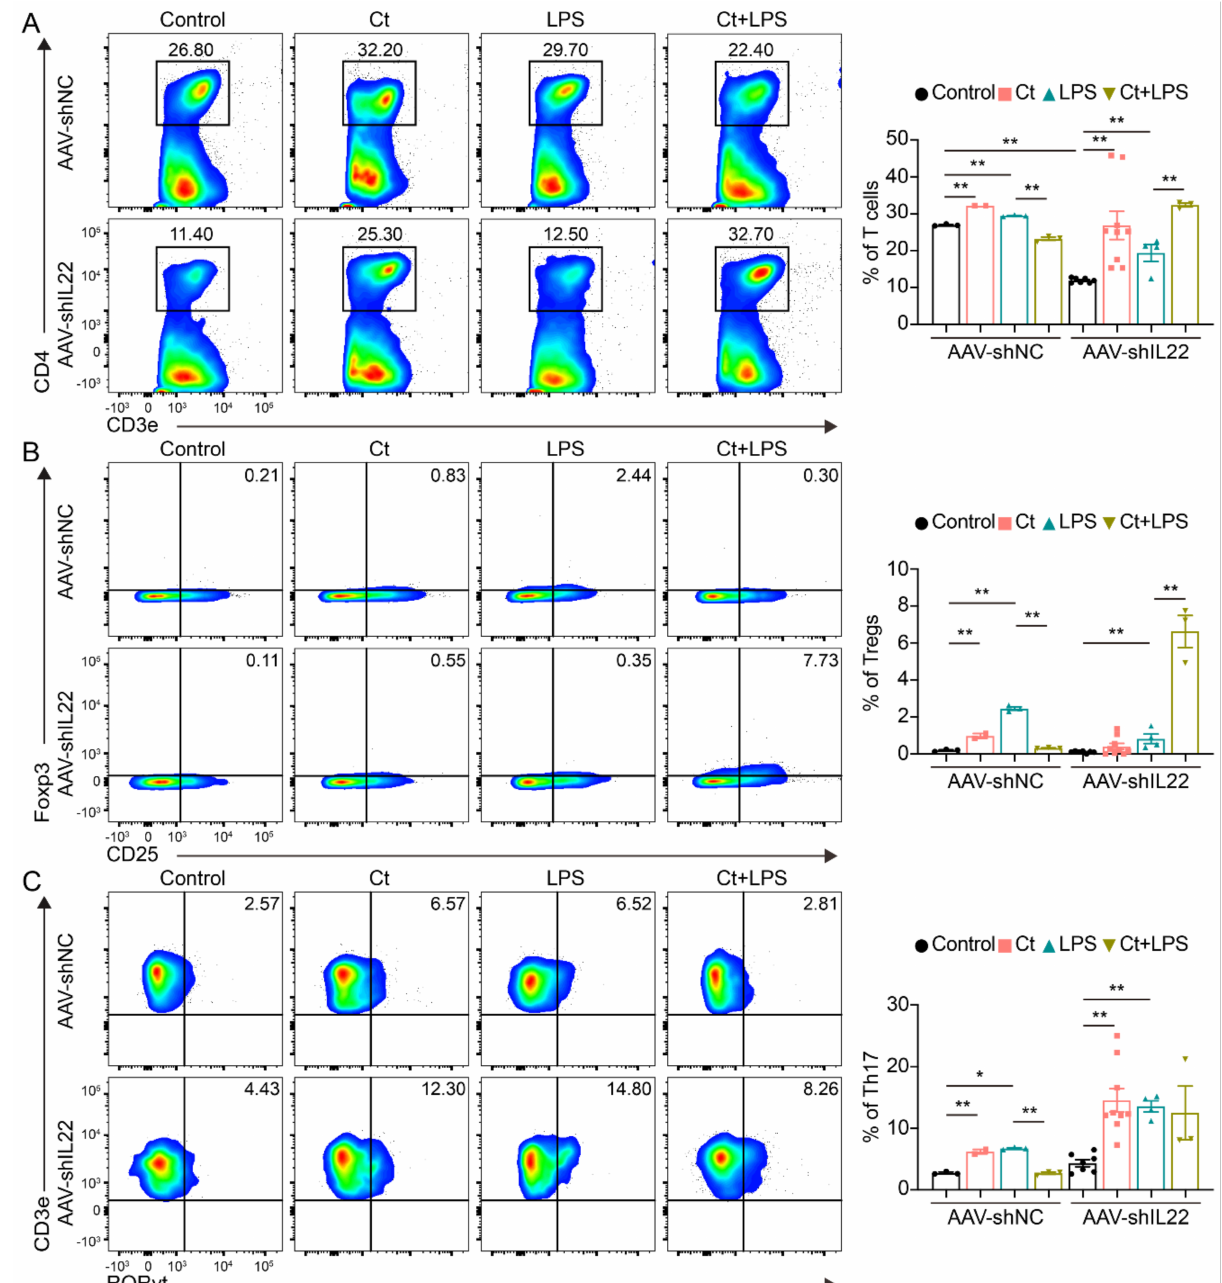
Figure 7. Effects of Ct on proportions of T cells, Tregs, and Th17 cells in mice knocking down IL-22. ( A ) Proportion of T cells; ( B ) proportion of Tregs; ( C ) proportion of Th17 cells. Each dot presented one mouse. Data presented as mean ± SEM. * p < 0.05, ** p < 0.01 by two-way unpaired t